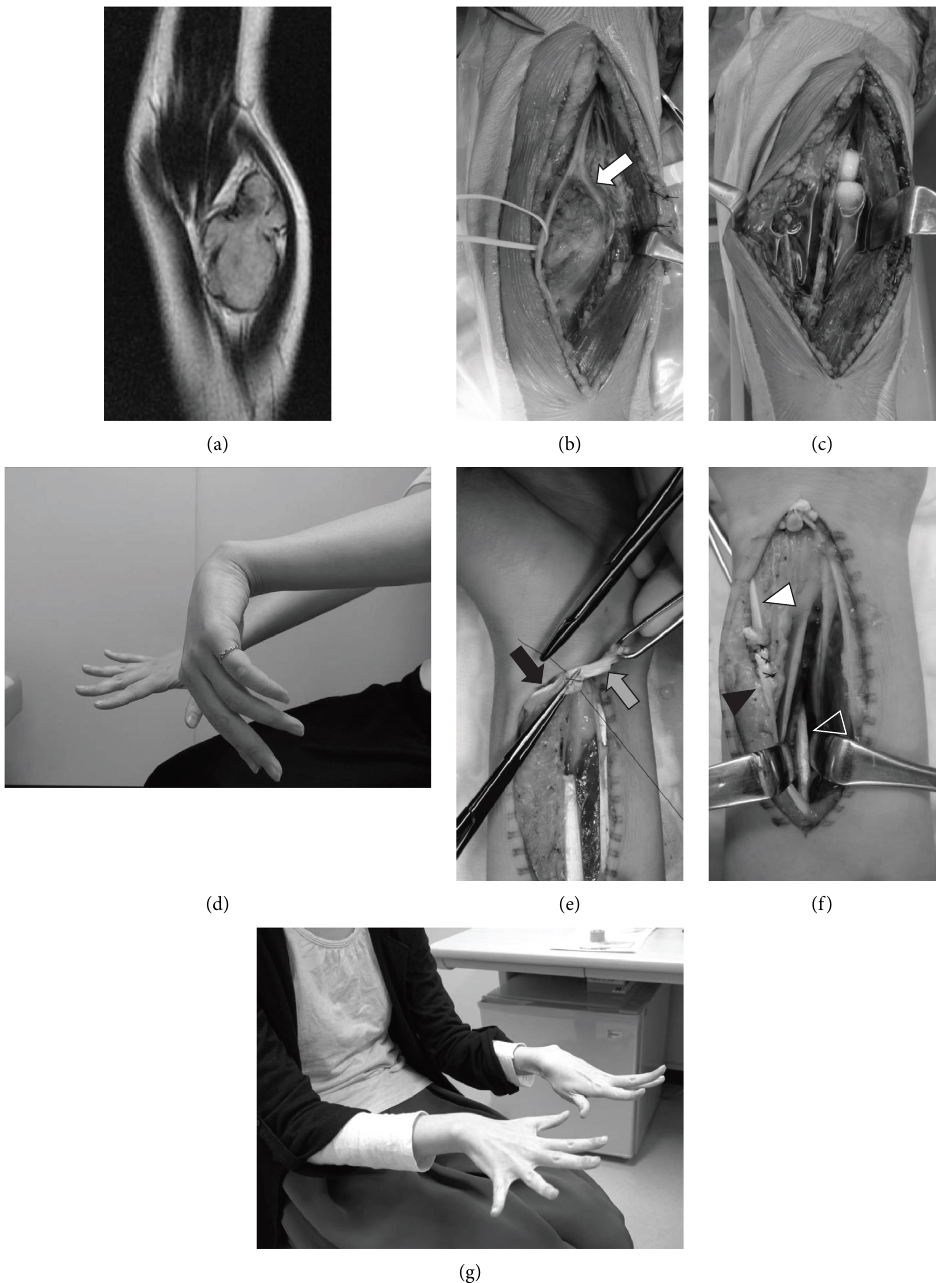
Figure 2: A 23-year-old female with a synovial sarcoma on the left elbow joint (case no. 8). MRI shows the iso-intensity tumor (53 × 32 mm) on T2WI (a). Te posterior intraosseous nerve is involved in the tumor (white arrow) (b). Te wide excision is performed and combined excision with joint capsule and posterior intraosseous nerve (PIN) (c). Te patient shows the PIN palsy after 2 years (d). Te tendon transfer (tsuge method) is performed 2 years after the initial surgery. Te fexor carpi radialis (FCR) (grey arrow) is transferred to the abductor pollicis longus (black arrow) (e). Te palmaris longus (black arrowhead) is transferred to the extensor pollicis longus (white arrowhead) and the FCR (white line arrowhead) is transferred to the extensor digitorum communis (f). Te patient demonstrates full extension of fngers 2 years after the second surgery